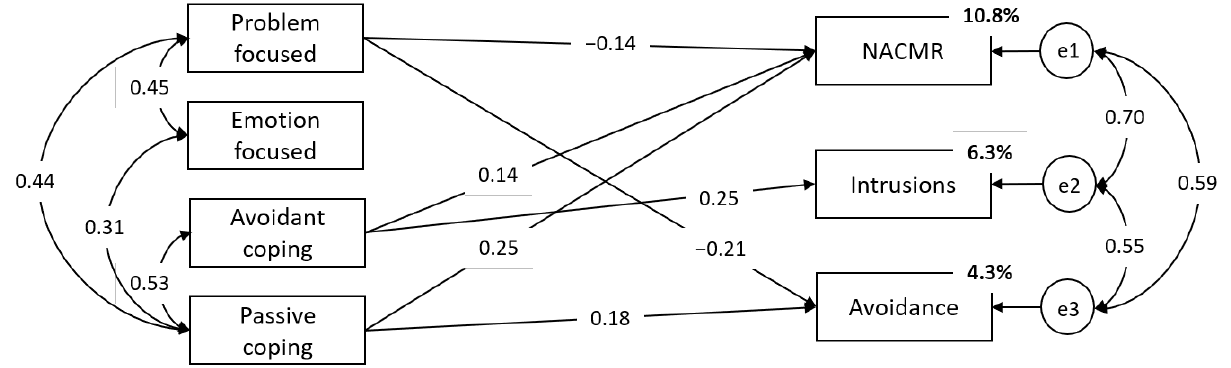
Figure 1. Relations between Problem-focused, Socially supported emotion-focused, Avoidant, and Passive coping with STS.